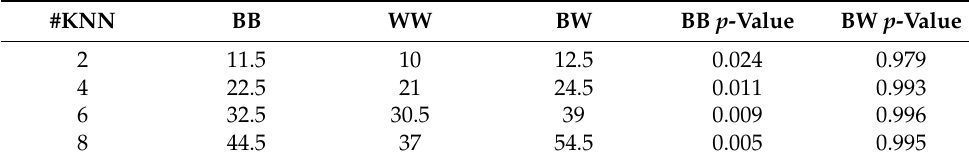
Table 6. Joint count statistics for spatial autocorrelation in Afghanistan.